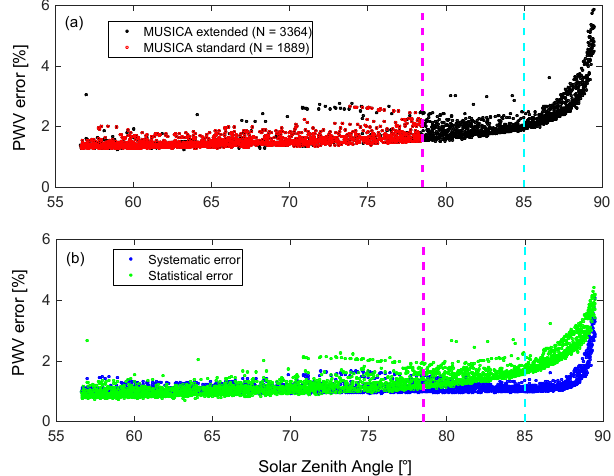
Figure 5. Eureka MUSICA water vapour total error vs. SZA. The dashed magenta line denotes the 78.5 ◦ SZA criterion which is part of the standard MUSICA quality control. The dashed cyan line de- notes the 85 ◦ SZA threshold used in this study for water vapour total column comparisons. (a) The total error. (b) The statistical and sys- tematic errors. The MUSICA extended dataset includes data usually filtered out by MUSICA’s quality control